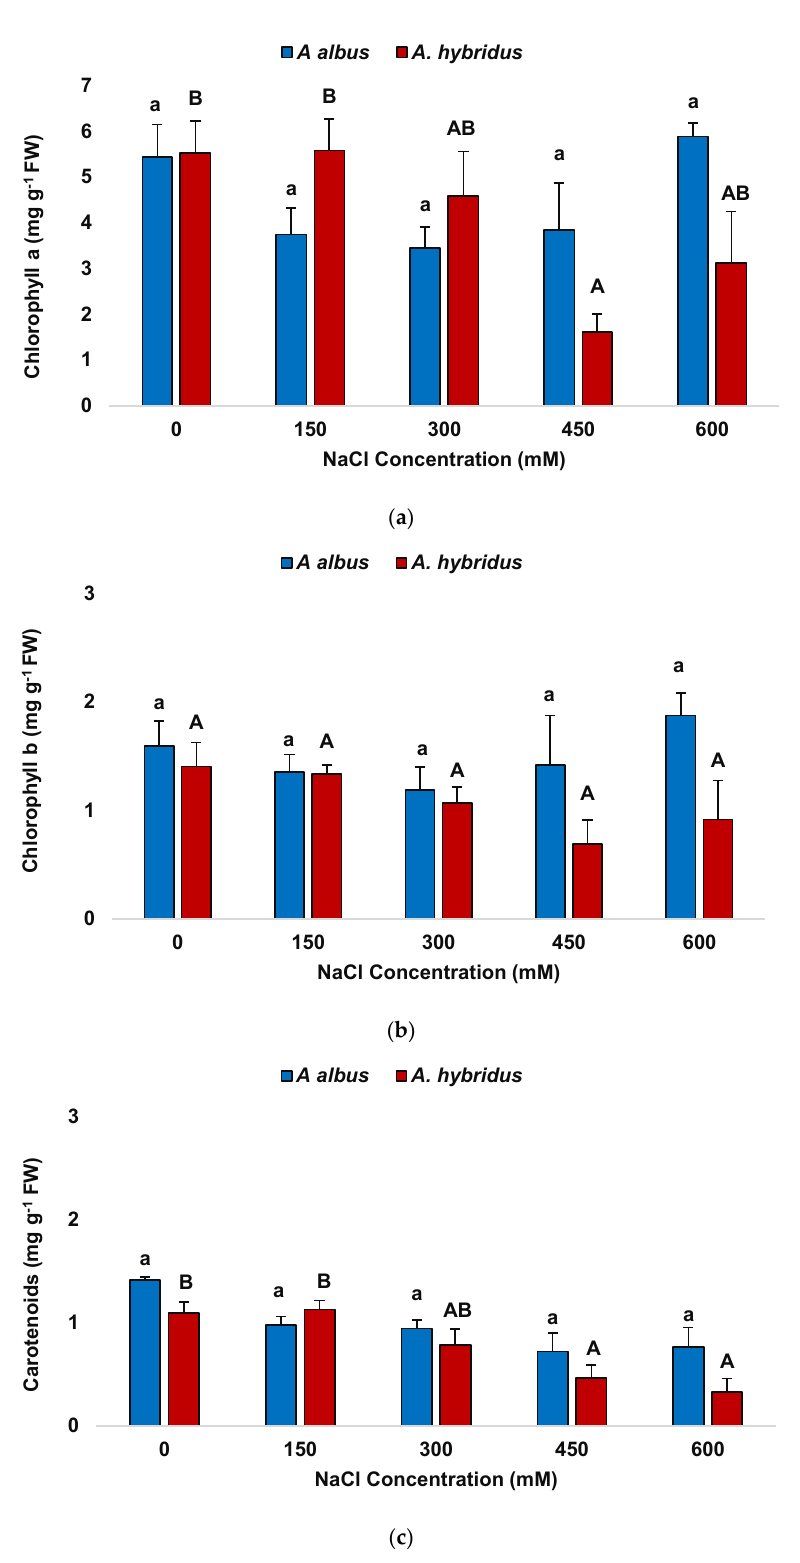
Figure 7. Concentration of chlorophyll a ( a ), chlorophyll b ( b ) and carotenoids ( c ) in the two Ama- ranthus species after one month of NaCl treatments. Means ± SE, n = 7. Same letters indicate homogeneous groups between treatments for each species, according to the Tukey test ( α = 0.05). Lower-case letters were used for A. albus and capital letters for A. hybridus